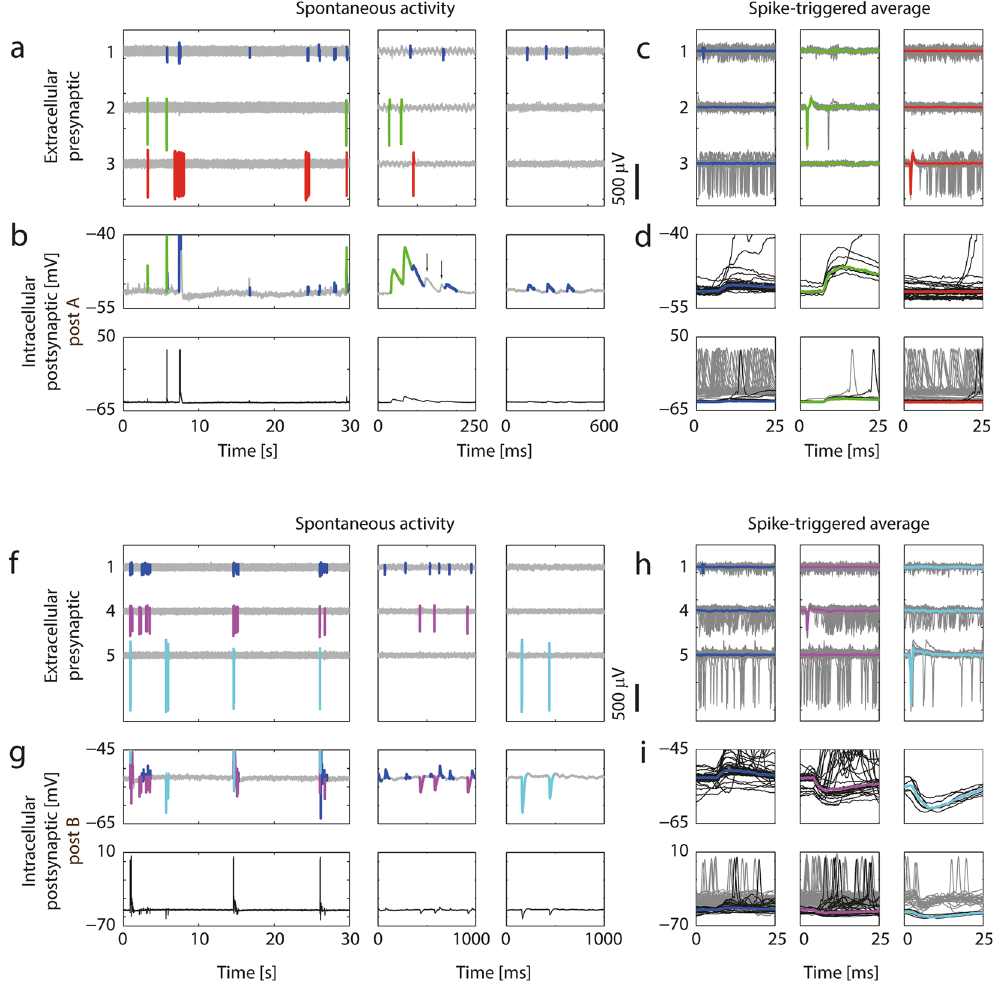
Figure 4. Mapping excitatory and inhibitory PSPs based on recordings of spontaneous activity. ( a ) Three data segments with different time scales ( left, center, right ) of recorded extracellular data from 3 electrodes. Spikes from 3 sorted neuronal units were colored; the blue and the green neuron were found to be presynaptically connected to the patched neuron ‘post A’, while the red neuron was not. ( b ) Top : Intracellular recordings from the patched cell. The signal trace after spikes of the blue and green neuron was colored in order to visualize excitatory PSPs originating from these two neurons, as determined by PSP averaging in ( d ). Note the summation of the synaptic events in the center plot, and that two additional EPSPs were measured, which, however, were not correlated to activity of the blue or green neurons (black arrows). Bottom : The same signal displayed with a larger amplitude range so that also postsynaptic APs can be seen. ( c ) STA of the extracellular APs extracted from a total of 2.5 minutes of recorded data (individual traces: gray; averaged waveforms are colored). ( d ) Top : Intracellular postsynaptic traces for the spikes of the colored neurons. Only traces that started from a baseline membrane potential (MP) value (i.e., did not exceed − 48 mV during the first 5 ms) are shown here. Note that the blue and the green neurons evoked EPSPs of different magnitude, and that no PSPs were seen following APs of the red neuron. The colored waveforms show the median MP trace. Bottom : The same traces on a wider MP range. Additionally, traces which were recorded at depolarized state (MP more positive than − 48 mV during the first 5 ms) are plotted in gray. ( f – i ) Equivalent plots for postsynaptic neuron B. In this example the violet and the cyan neurons evoked inhibitory PSPs (IPSPs) of different magnitudes, whereas the blue neuron evoked EPSPs. Note that the blue presynaptic neuron is the same than the one for ‘post A’ in Fig. 4(a–d). Spikes in h were extracted from 6 minutes of recorded